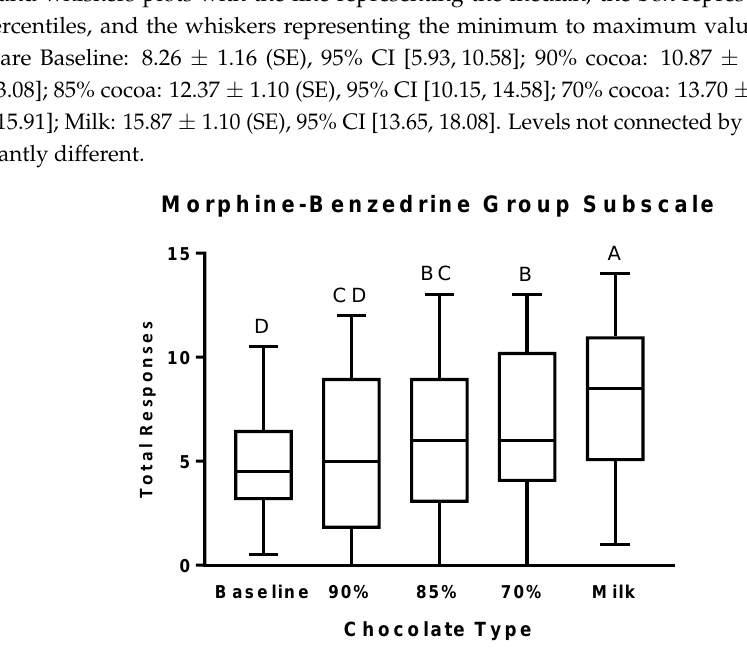
Figure 2. Morphine-Benzedrine Group (MBG) subscale scores after the consumption of chocolates differing in cocoa, sugar, and fat content. Self-reported scores on the MBG subscale are presented as box and whiskers plots with the line representing the median, the box representing the 25th to 75th percentiles, and the whiskers representing the minimum to maximum values. Least-squares means are Baseline: 4.28 ± 0.71 (SE), 95% CI [2.86, 5.69]; 90% cocoa: 5.37 ± 0.66 (SE), 95% CI [4.03, 6.70]; 85% cocoa: 6.10 ± 0.66 (SE), 95% CI [4.77, 7.43]; 70% cocoa: 6.63 ± 0.66 (SE), 95% CI [5.30, 7.97]; Milk: 7.97 ± 0.66 (SE), 95% CI [6.63, 9.30]. Levels not connected by the same letter are significantly